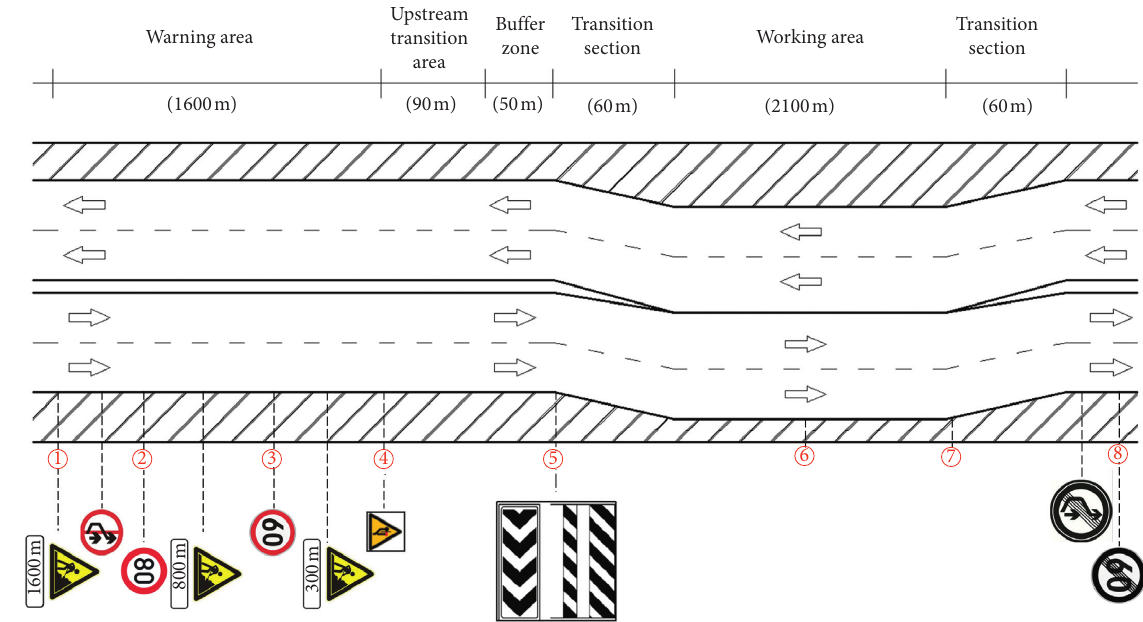
Figure 10: Collection point location. Table 6: Driving risk assessment results of a